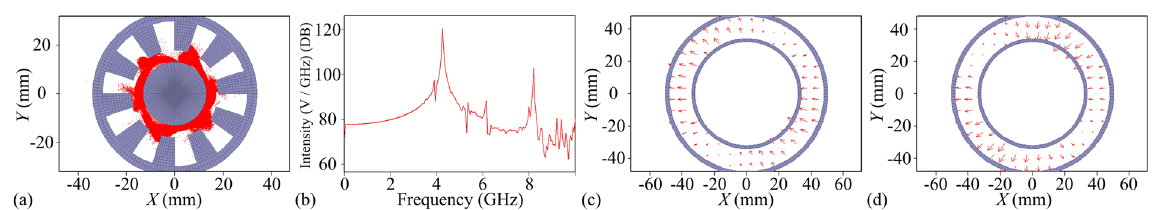
Figure 6. ( a ) Six electron spokes in the R θ plane of the ten-cavity RM. ( b ) Spectrums of electric fields in dB in the output port of the coaxial waveguide from 20 to 40 ns. ( c ) TE 11 mode in the output port at 29.323 ns. ( d ) TE 11 mode in the output port at 30.779 ns.